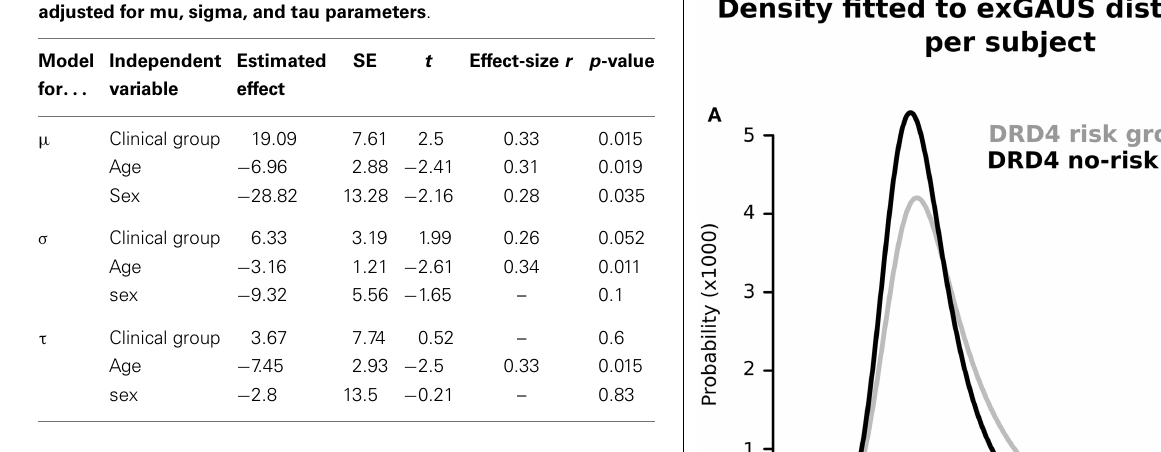
Table 2 for a summary of comparisons between DRD4/SCL6A3 genotype groups). Interestingly, linear models demonstrated a statistically significant effect of the “genotype group” × “clinical